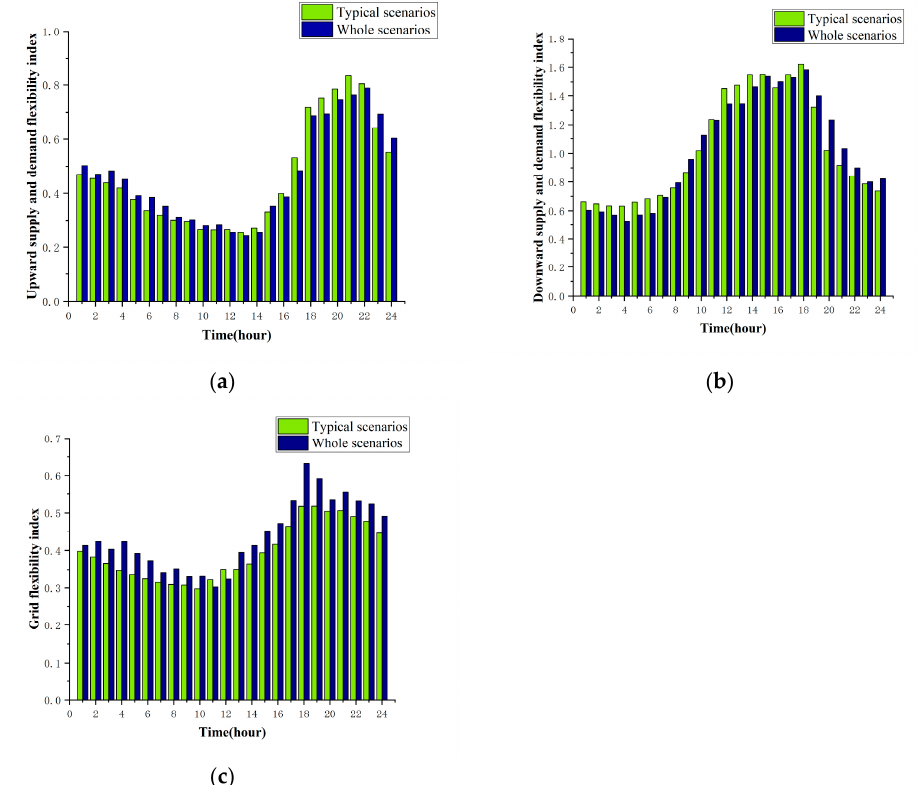
Figure 12. Comparison of flexibility index of Zone 1. ( a ) upward supply and demand flexibility index. ( b ) downward supply and demand flexibility index. ( c ) grid flexibility